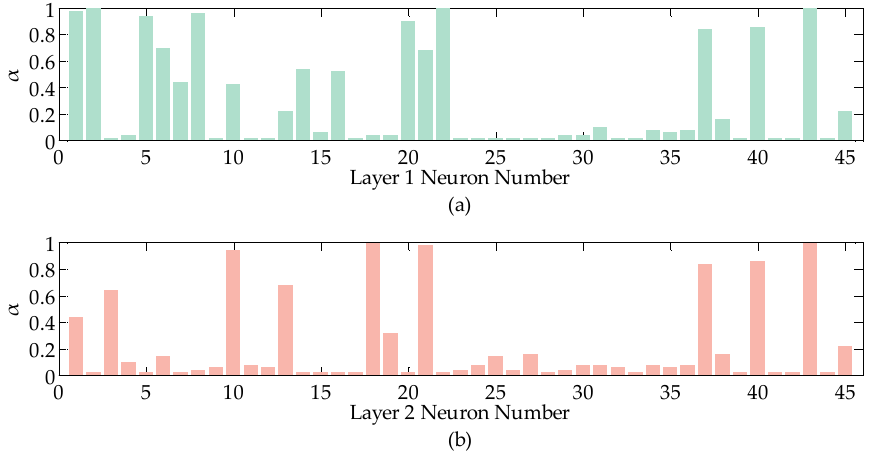
Figure 5. Weighting factor α of each neuron. ( a ) represents the selected α value of the first layer of network neurons and ( b ) represents the selected α value of the second layer of network neurons.